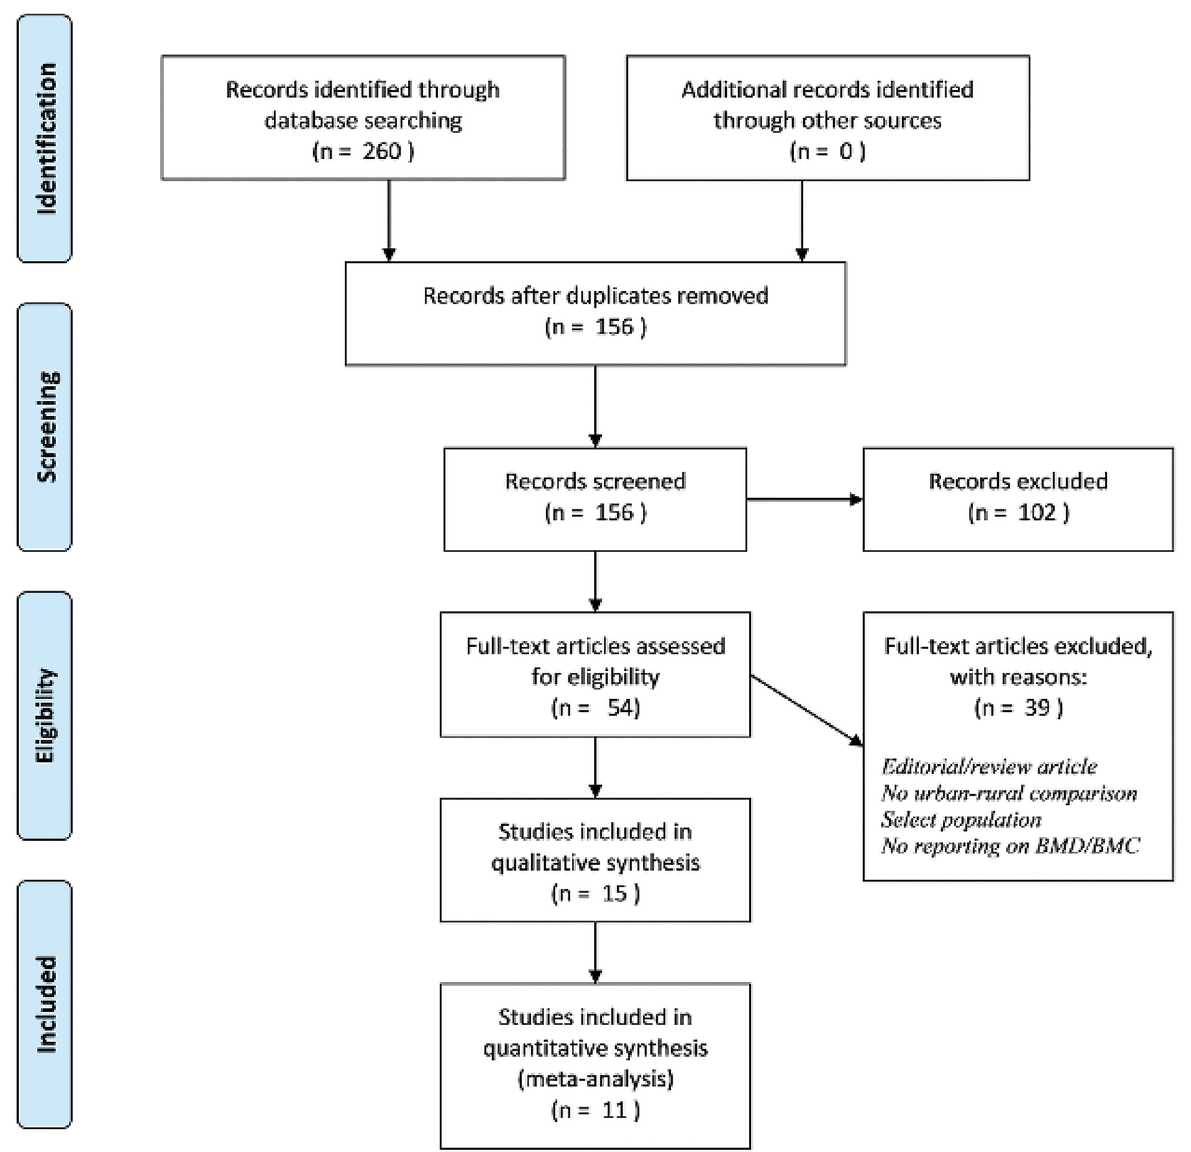
Fig 1. Flow diagram of study selection process from initial search to included